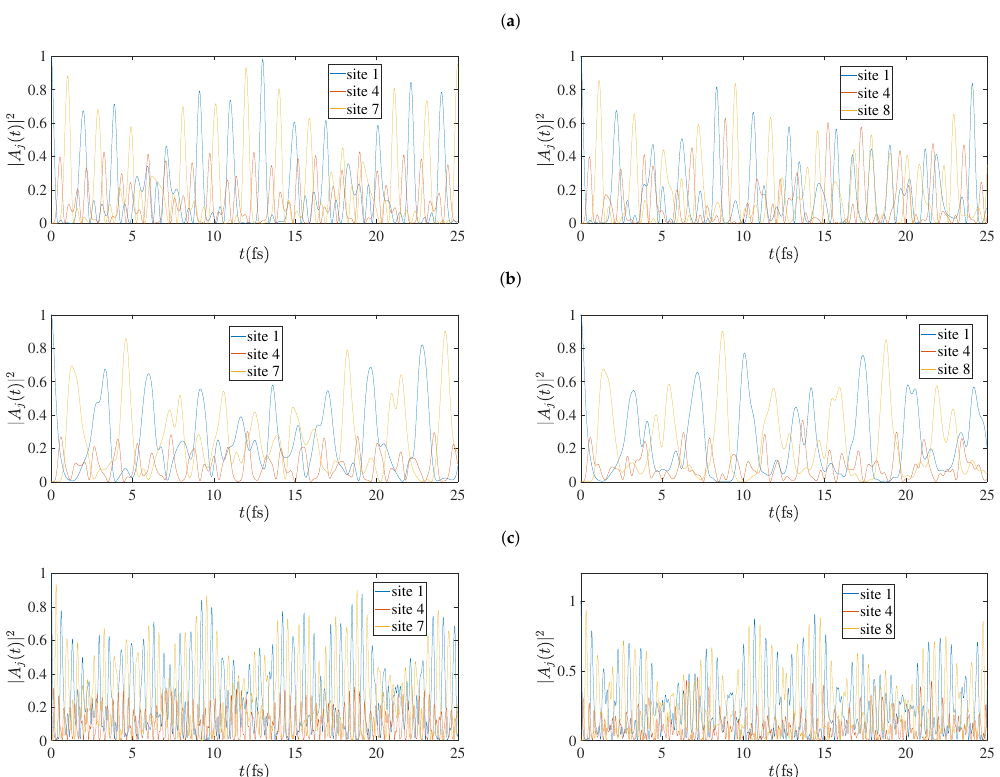
Figure 13. Charge oscillations obtained by the TB variants ( a ) TBI, ( b ) TBImod, ( c ) TBImodt4times, for cumulenic molecules with N = 7 (left column) and N = 8 (right column).